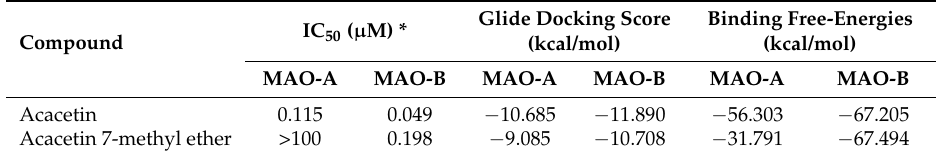
Figure 6. Three-dimensional (3D) protein-ligand interactions of acacetin (C magenta, stick model) and acacetin 7-methyl ether (C cyan, stick model) with the X-ray crystal structures of MAO-A and MAO-B. ( A ) Acacetin with MAO-A, ( B ) acacetin 7-methyl ether with MAO-A, ( C ) acacetin with MAO-B, and ( D ) acacetin 7-methyl ether with MAO-B. FAD (C green, stick model), some crystallographic waters (O red, H gray, stick model), and the important residues of MAO-A and MAO-B (C gray) are also shown. The black dashed lines represent H-bonding. Table 3. Glide docking scores and binding free energies of acacetin and acacetin 7-methyl ether to MAO-A and